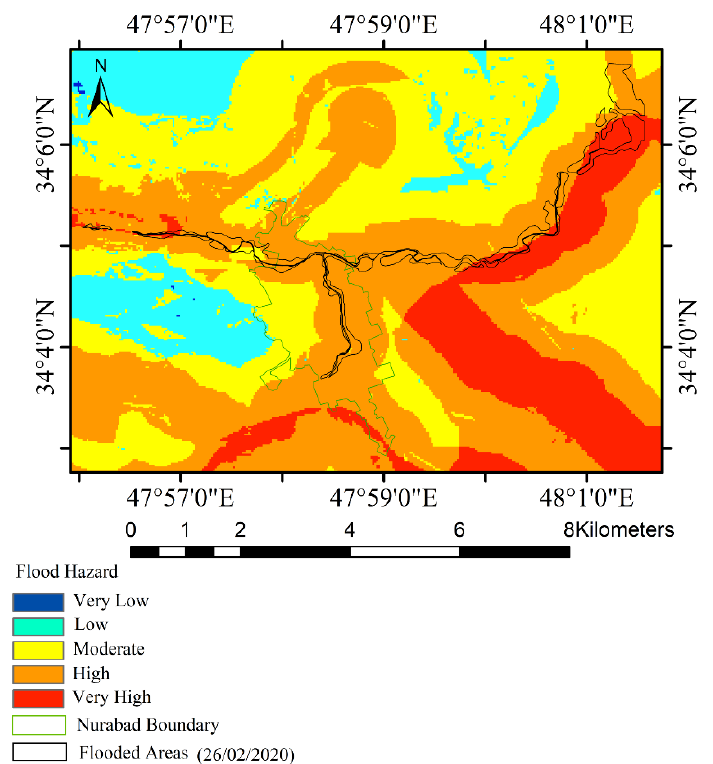
Figure 12. A comparison of the areas affected by a flood in the Nurabad watershed on 26 February 2020 (obtained from Copernicus Emergency Management Service (CEMS) reports) and the produced flood hazard map using the proposed method in this study.